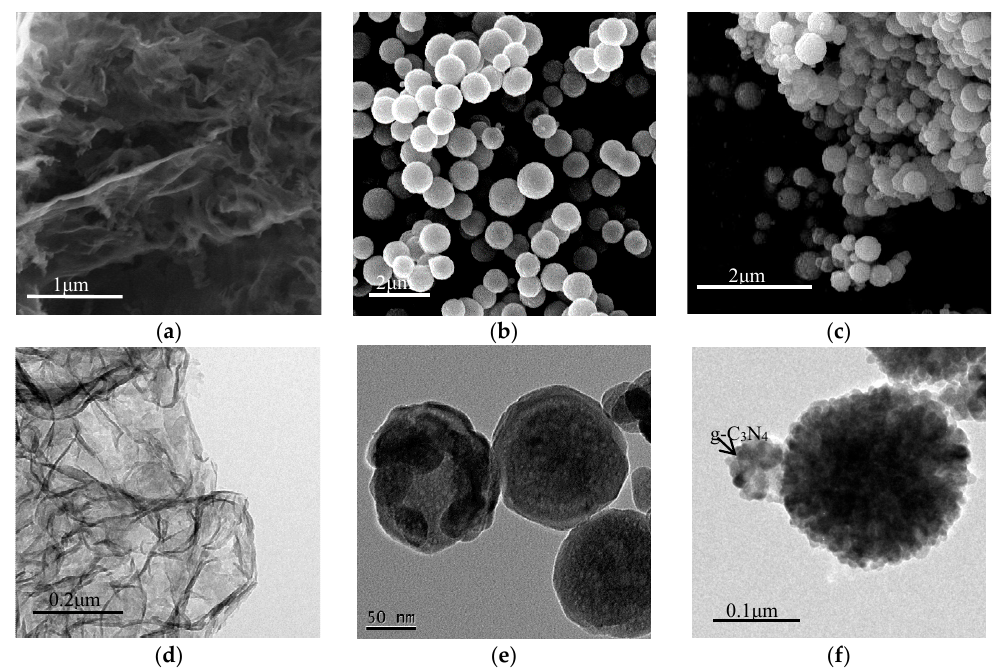
Figure 3. Scanning electron microscope (SEM) images of ( a ) g-C 3 N 4 ; ( b ) MgFe 2 O 4 porous microspheres and ( c ) MgFe 2 O 4 /g-C 3 N 4 composite; as well as transmission electron microscopy (TEM) images of ( d ) g-C 3 N 4 ; ( e ) MgFe 2 O 4 porous microspheres and ( f ) MgFe 2 O 4 /g-C 3 N 4 composite.